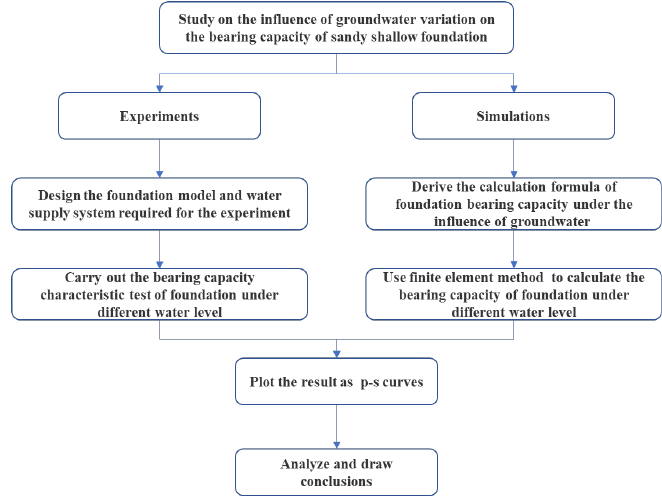
Figure 1. Flowchart of the overall research.